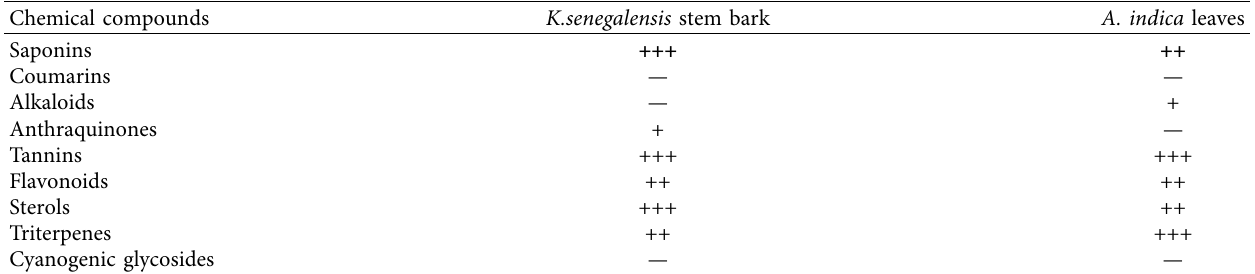
Table 5: Phytochemical compounds detected in 80% hydroethanolic extracts from K. senegalensis stem bark and A. indica leaf. Chemical compounds Coumarins